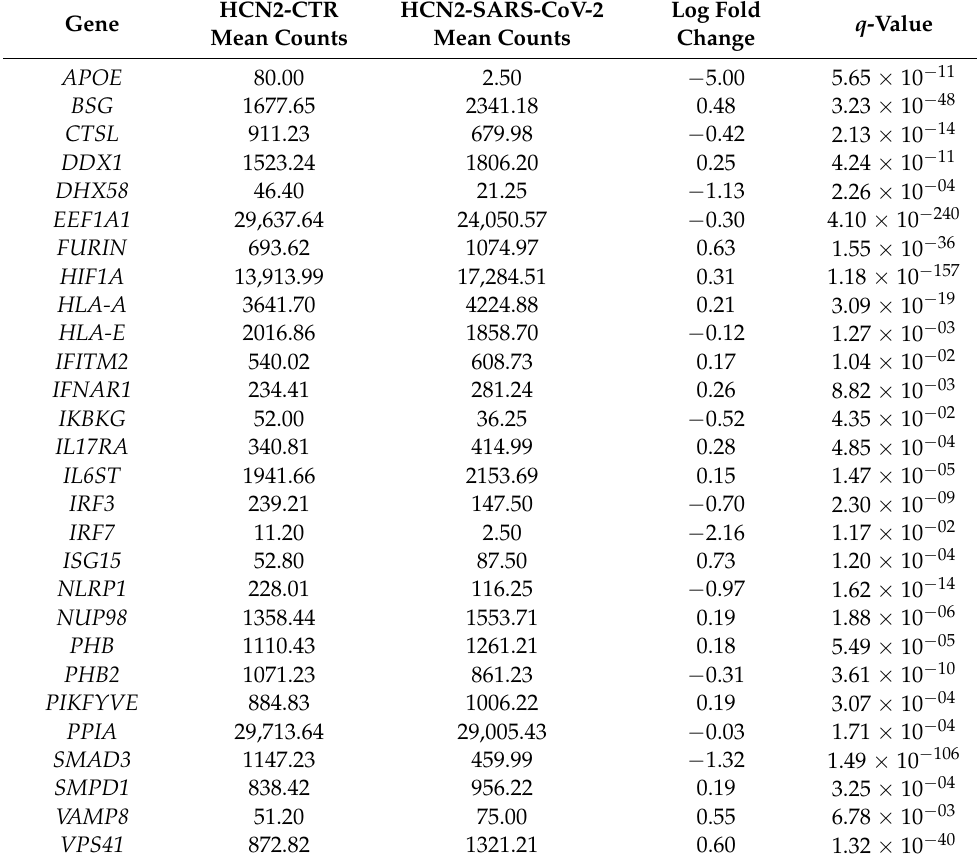
Table 4. DEGs associated with SARS-CoV-2 infection in